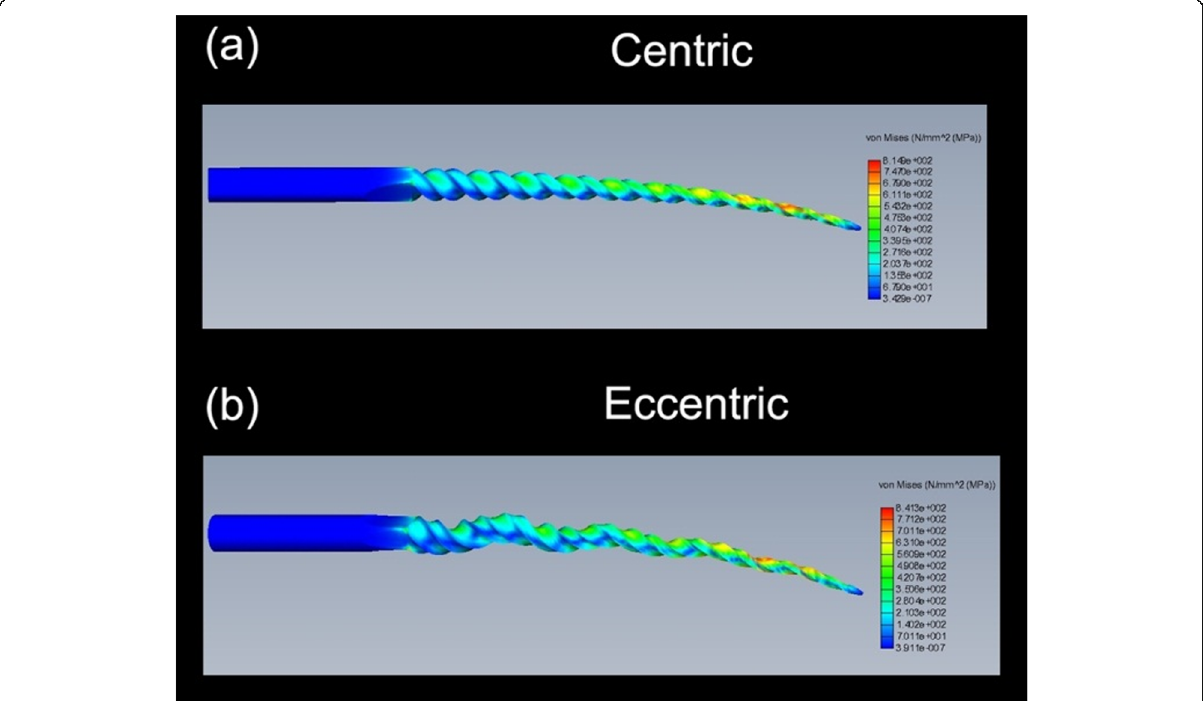
Fig. 9 Stress distribution during bending of different tested file centricity of the cross section. a Centric cs. b Eccentric cs